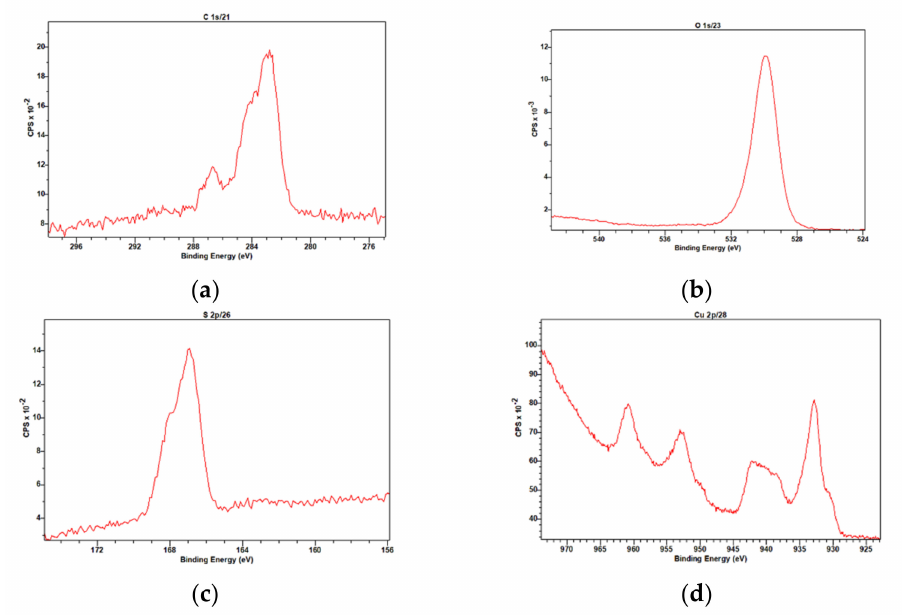
Figure 7. High-resolution XPS C1s ( a ), O1s ( b ), S2p ( c ) and Cu2p ( d ) spectra of